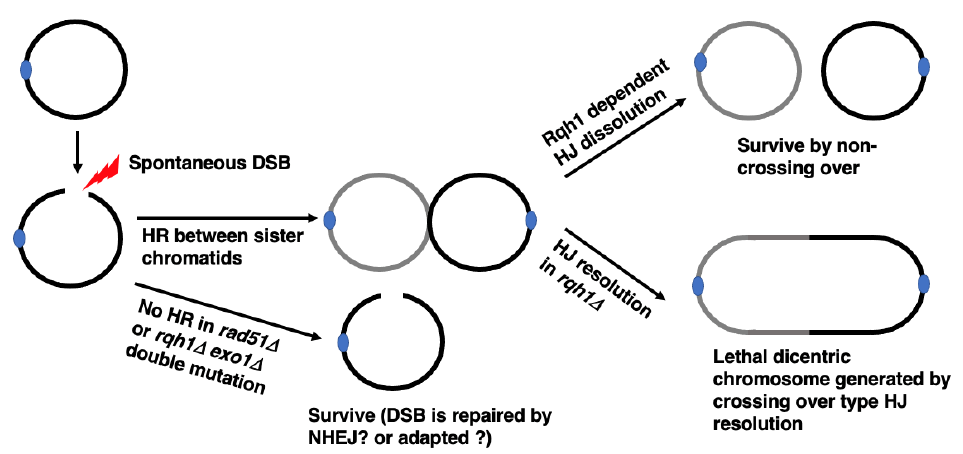
Figure 2. Consequence of HR in cells with circular chromosomes in the absence or presence of Rqh1. Spontaneous DSB in a circular chromosome would result in Exo1 and/or Rqh1 dependent DSB end processing and Rad51 dependent generation of recombination intermediates between sister chromatids. This intermediate can be resolved without crossing over by Rqh1-Top3 dependent double Holliday junction (HJ) dissolution. In the absence of Rqh1, this intermediate will be resolved by nuclease(s), which could generate dicentric circular chromosome dimer by crossing over. Even if spontaneous DSB in a circular chromosome is not repaired by HR due to the defect in HR activity, this DSB would not result in cell death, possibly due to adaptation or to NHEJ dependent DSB repair.